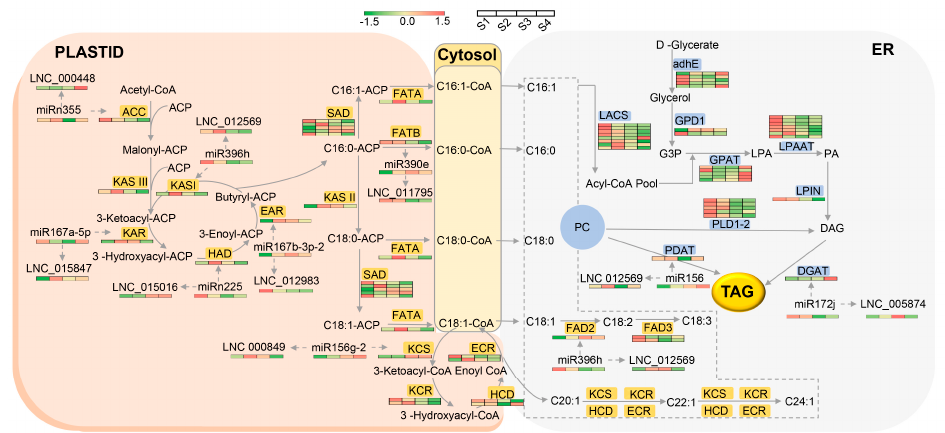
Figure 13. Schematic diagram representing FA biosynthesis and oil accumulation in yellowhorn seeds. Key DEL–DEM–DEG modules and their expression levels in the transcriptome are marked in this diagram.